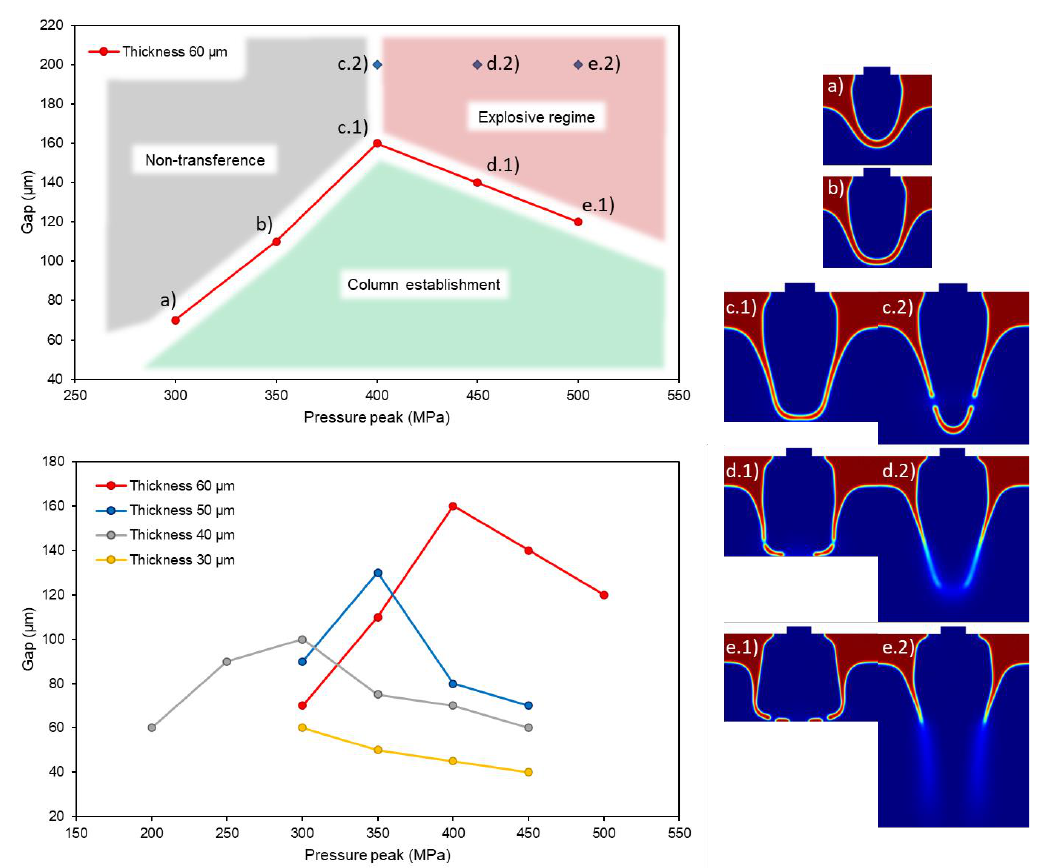
Figure 12. Study of the maximum gap for the formation of a columnar structure. Analysis for a single fluid thickness (60 µ m) in which the three main regimes are distinguished: non-transference, column formation and explosive regime (upper graph), and comparison for different thicknesses (30 to 60 µ m) in which the maximum is displaced to lower values of gap and pressure (lower graph).